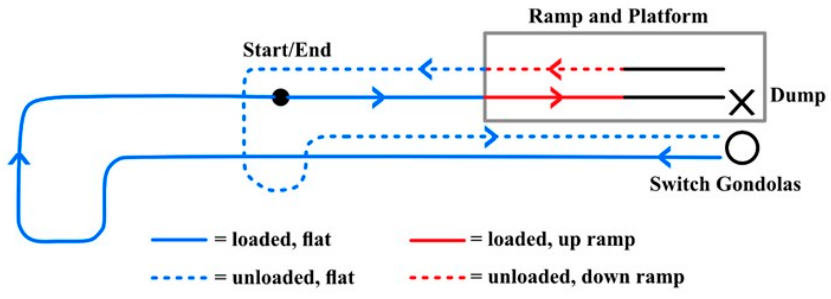
Figure 4. Movement path in Task 1.